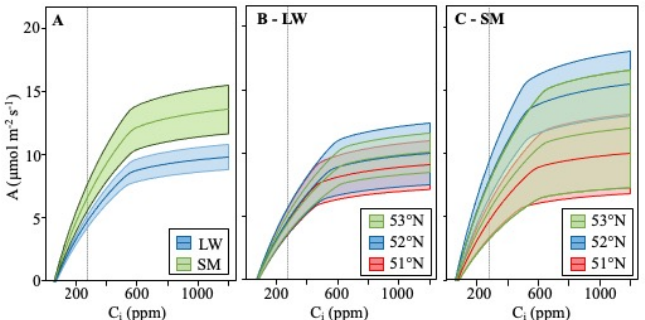
Figure 2. RACiR curves of SM and LW averaged for all latitudes ( A ) and LW and SM along a latitudinal gradient (( B , C ), respectively). Colored areas represent 95% confidence intervals, and the dashed line represents the mean Ci at ambient CO 2 concentration (405 ppm).